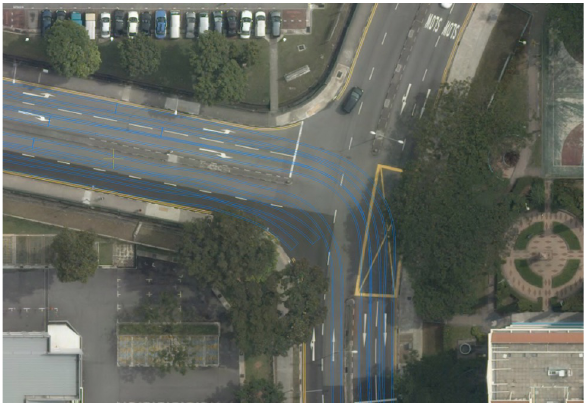
Figure 2. Blue lines indicate the outlines of multiple overlapping scan tracks for a single